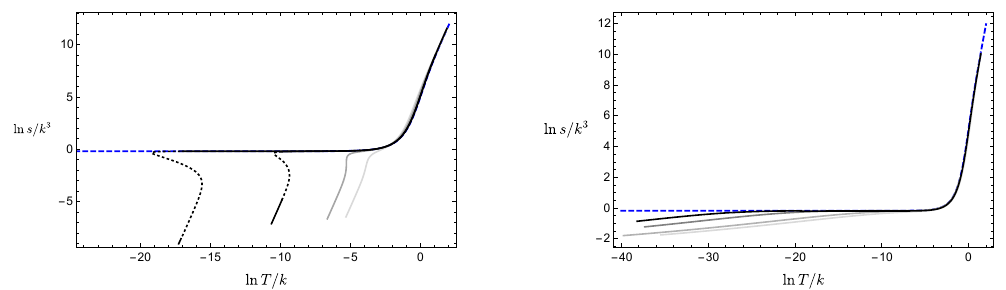
Figure 7 . Plots of the entropy density s as a function of T for black hole solutions with various deformation parameters and for models with m 2 = (cid:0) 15 = 4 and (cid:24) = (cid:0) 1 = 4. The left plot is for (cid:0) =k 3 = 2 (cid:20) (cid:22)(cid:0) (cid:24) 19 : 37, namely 5 : 5, 10 : 3, 18, and 19 : 3 (light grey to dark grey). The dashed blue line in both plots is for (cid:0) =k 3 = 2 = (cid:22)(cid:0). For (cid:0) =k 3 = 2 = 19 : 33 and 19 : 36 we have used dotted lines on the curves to indicate the (cid:12)rst order phase transition. As T ! 0, for (cid:0) =k 3 = 2 < (cid:22)(cid:0) the black holes approach the boomerang RG (cid:13)ows, with s (cid:24) T 3 , and when (cid:0) =k 3 = 2 = (cid:22)(cid:0) they approach the AdS 0 to AdS 2 (cid:2) R 3 RG (cid:13)ow with, from (5.2), s (cid:24) 0 : 84 k 3 . The right plot is for (cid:0) =k 3 = 2 (cid:21) (cid:22)(cid:0), namely, 19 : 41, 19 : 75, 25 and 35 (dark grey to light grey). As T ! 0 the black holes have s ! 0, but not as a power of T . At T ! 0 they approach insulating ground states. In both plots the intermediate scaling regimes can be